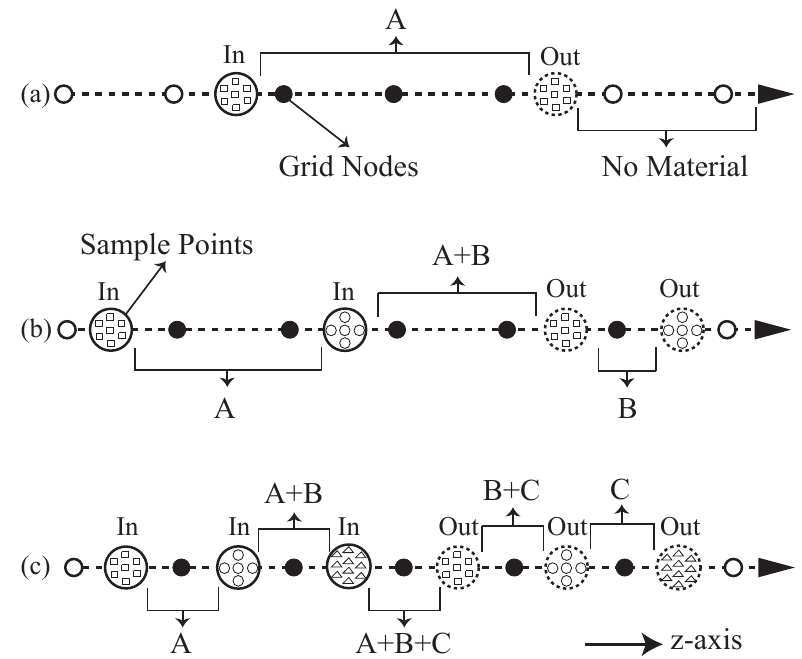
Figure 6. Determining materials for grid-nodes by LDMI sample points. ( a ) Single material. ( b ) Two materials. ( c ) Three materials. Note that the z -axis is pointing to the